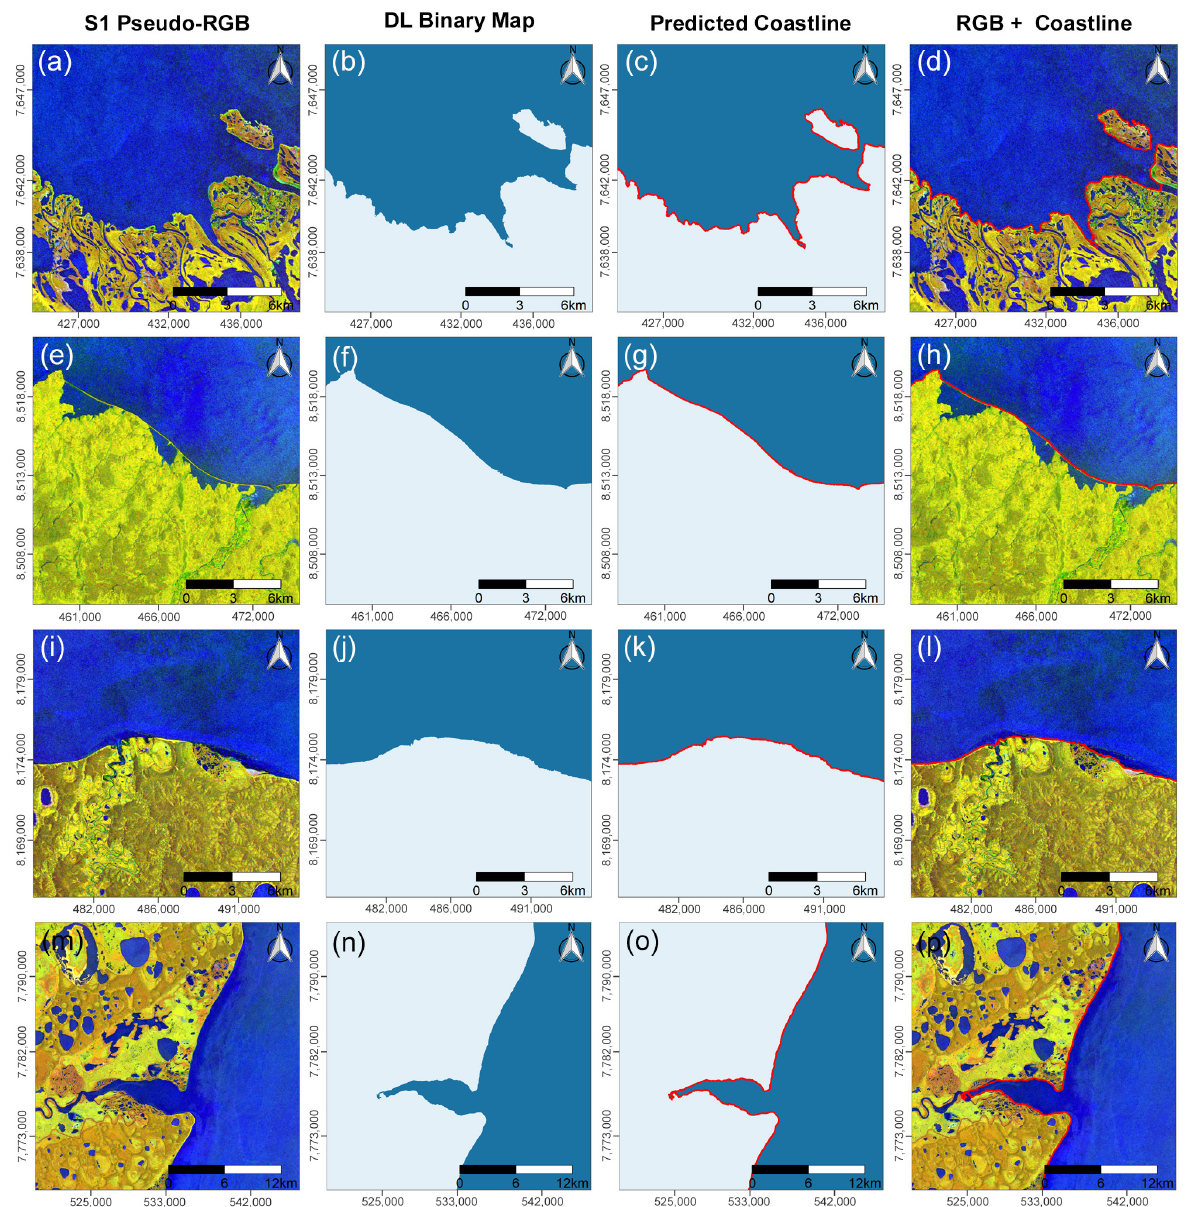
Figure 8. Subsets of annual S1 pseudo-RGB images, the resulting DL-based binary classification maps, and the derived coastlines for four different regions, including Shoalwater Bay in Canada (aoi 03) ( a – d ), Sims Bay in Russia (aoi 05) ( e – h ), Mus-Khaya Cape–Mouth of Peshanaya in Russia (aoi 06) ( i – l ), and Mouth of Kurdugina–Malyy Chukochiy Cape in Russia (aoi 10) ( m – p